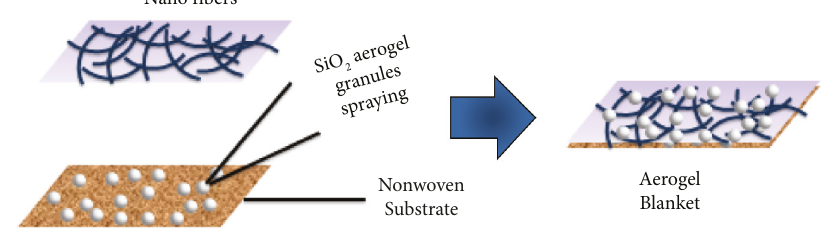
Figure 10: Schematic diagram for the lamination method.